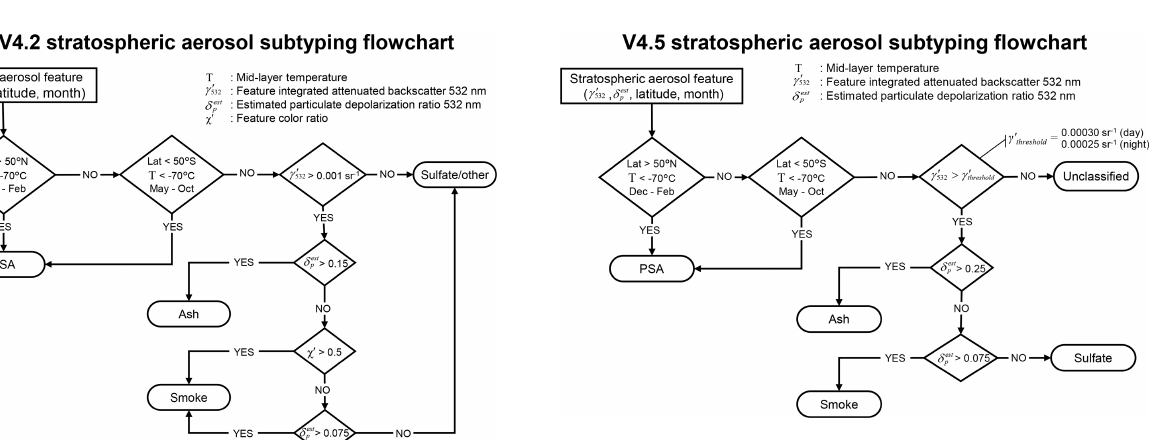
Figure 7. Flowchart for stratospheric aerosol subtyping in the